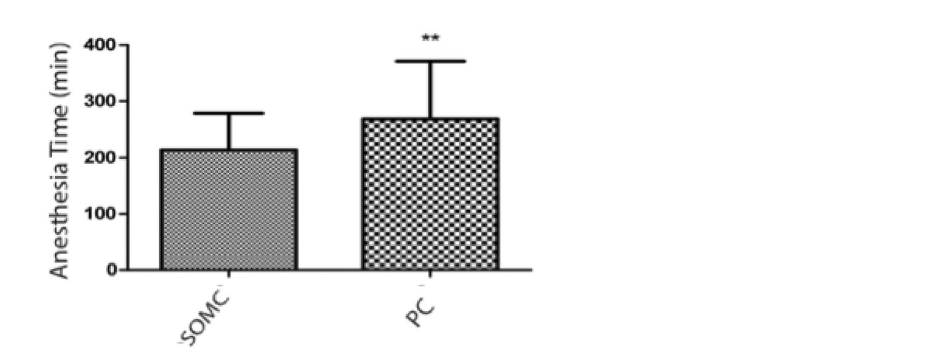
Figure 2. Graphs of anesthesia time (in minutes) of patients who underwent surgical treatment of cerebral aneurysms, including all aneurysms. The supraorbital minicraniotomy (SOMC) and pterional craniotomy (PC) techniques were used. The bars represent the average ± standard deviation for SOMC (n = 34) and PC (n = 44) accesses in patients who underwent aneurysm surgery (**p = 0.0081; unpaired Student’s t